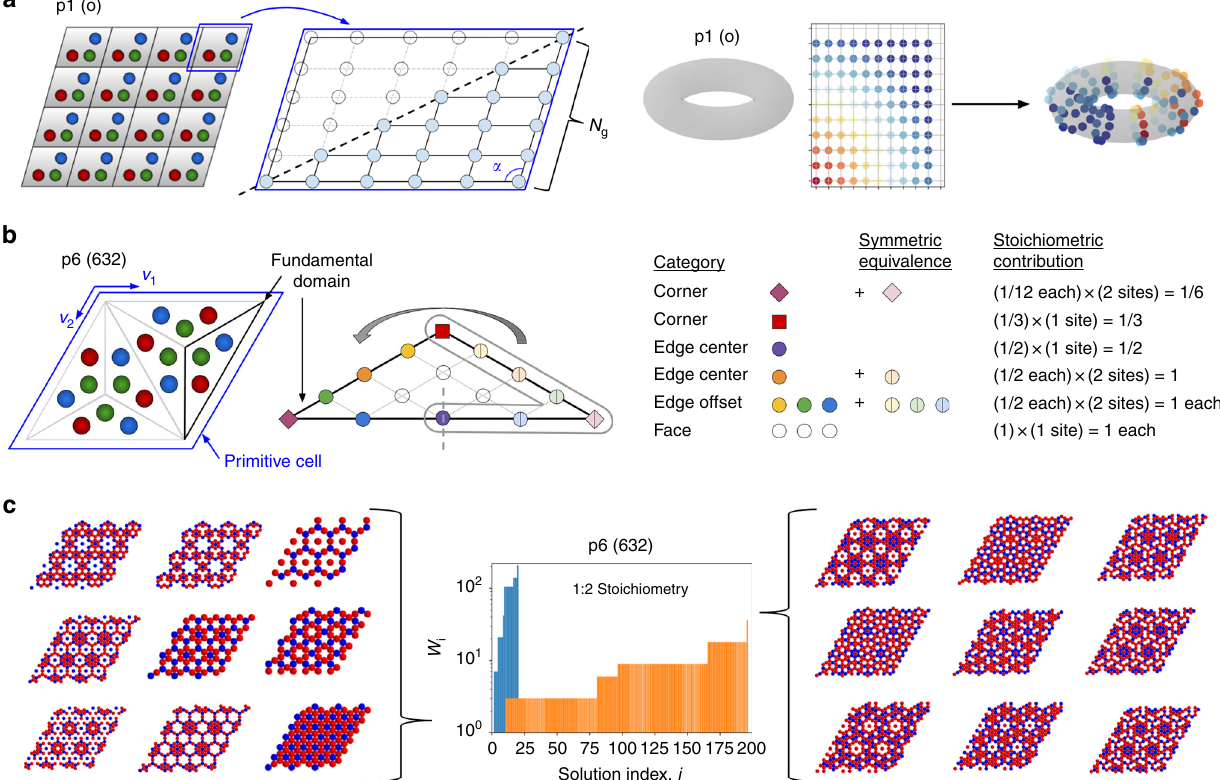
Fig. 1 Summary of candidate enumeration strategy. a Discretization of a periodic p1 primitive cell into nodes. Symmetry introduces boundary conditions which constrain the placement of particles on the grid as if it were mapped onto the surface of a torus. This represents the orbifold of the p1 wallpaper group. b Fundamental domain and primitive cell for the p6 group; edge nodes are circled in gray on the right and will be wrapped on top of symmetrically equivalent nodes on the left. Here there are 6 node categories we could consider, which may be reduced to 4 if ones with the same stoichiometric contribution are combined. c Representative solutions to the CSP for the p6 lattice shown in b for a binary mixture with a 1:2 stoichiometric ratio of components. Images on the left are drawn from the solutions with the lowest 5% of realizations, and those on the right from the solution with the most. The blue histogram represents the case where node categories with the same stoichiometric contribution are combined, while the orange corresponds to when they are kept separate; the total number of solutions is the same for